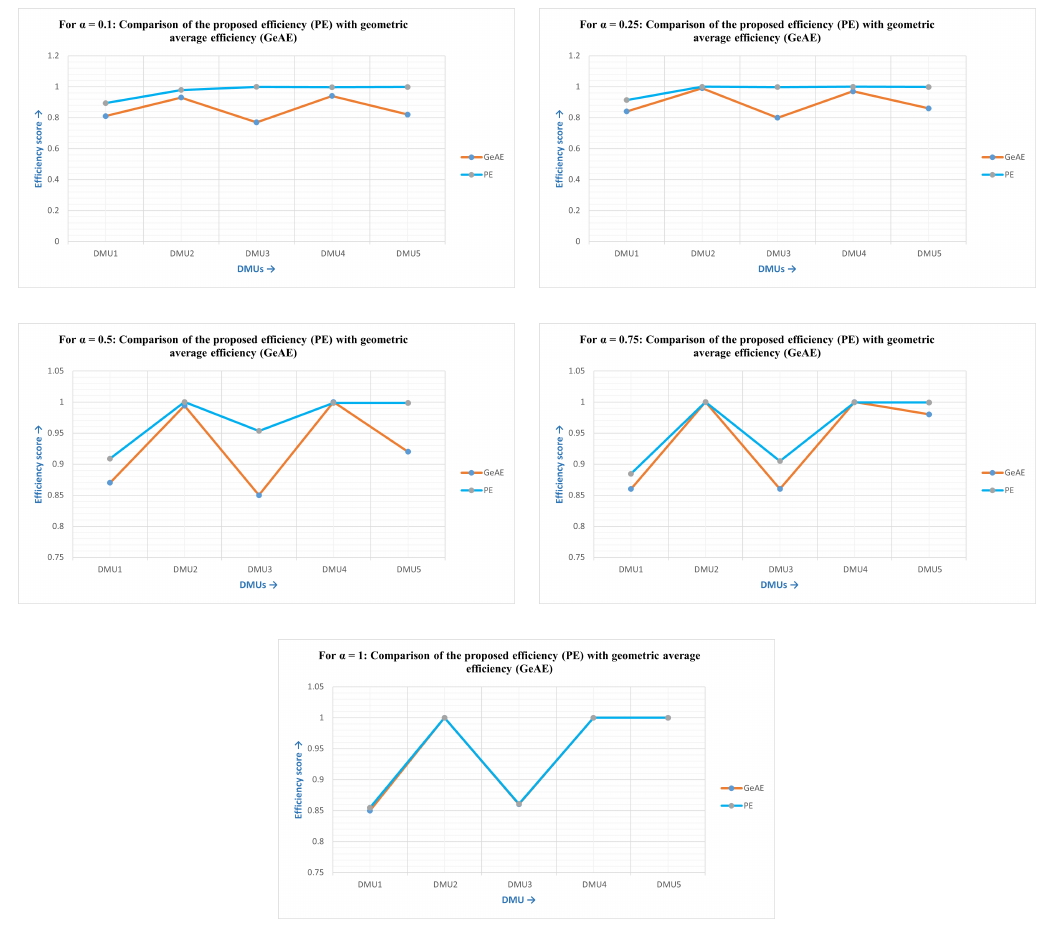
Figure 2. Comparison between the proposed efficiency and Geometric average